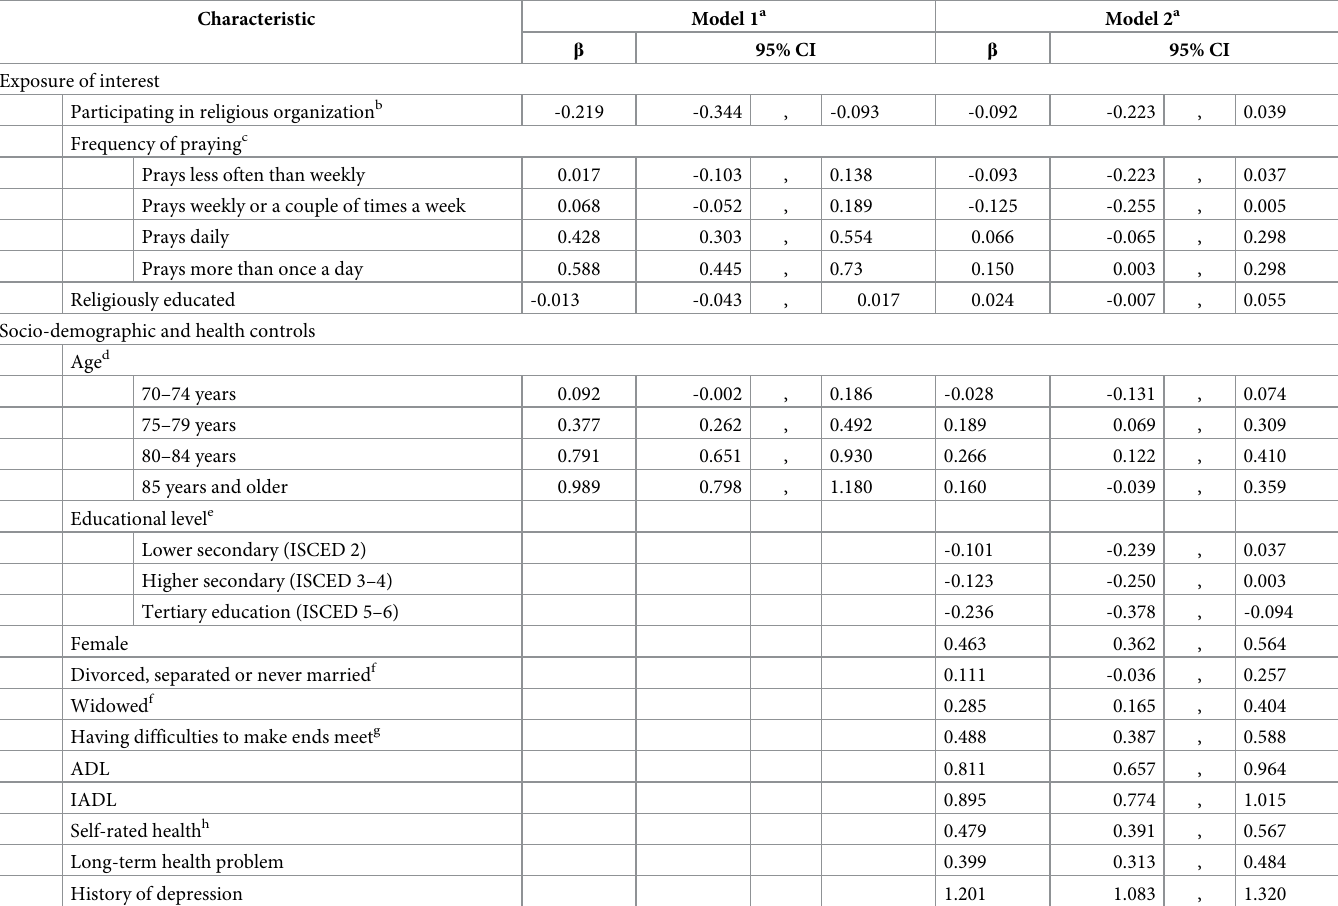
Table 3. Random effects models, religiousness and depressive symptoms among respondents aged 65 years or older, survey of health, ageing and retirement, 2004– 2013.